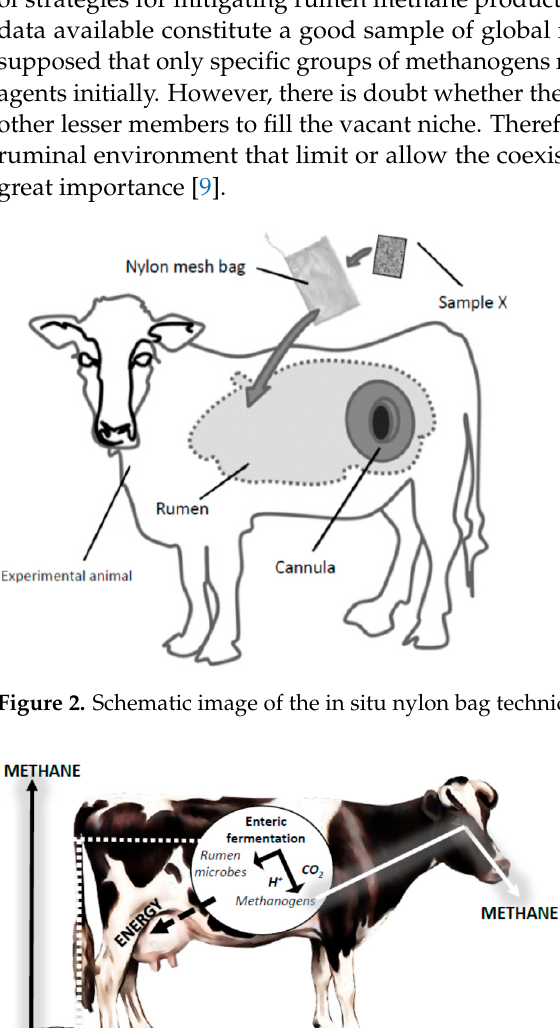
Figure 3. Schematic representation of the fermentative processes occurring in the rumen (adapted from Kumari et al. [16]).